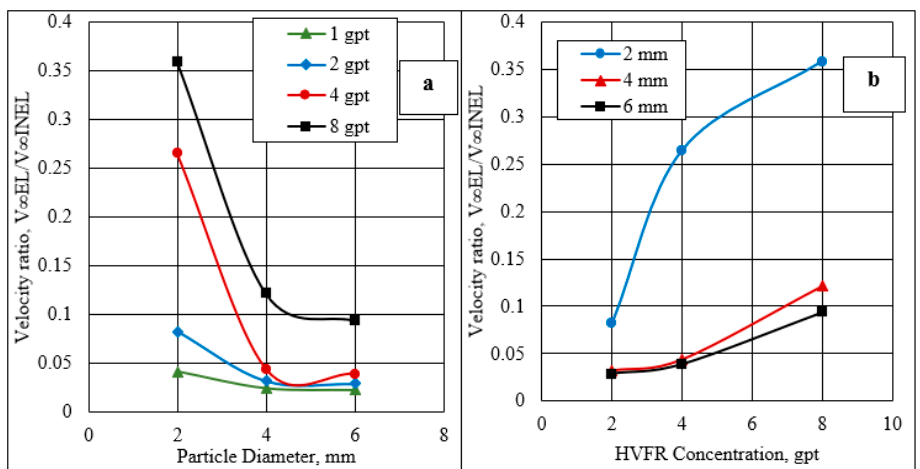
Figure 11. Velocity ratio using: ( a ) friction reducer concentrations and ( b ) spherical particle sizes.